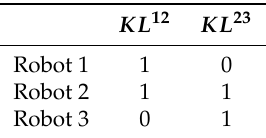
Table 3. The simplified signature matrix of robot 2.